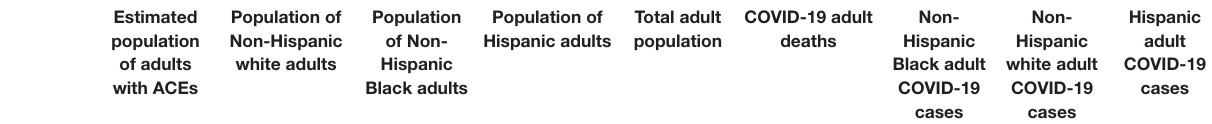
TABLE 2 | Spearman rank correlation test results ( n = 46; rho value ( p -value)